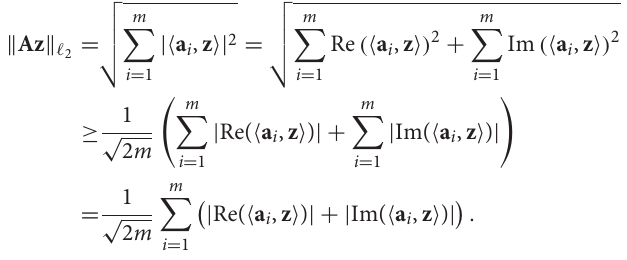
Numerical results for orthogonal arrays: Figure 1 summarizes the empirical performance of basis pursuit (1) from independent orthogonal array measurements. We consider real-valued signals x and quantify the performance in terms of the